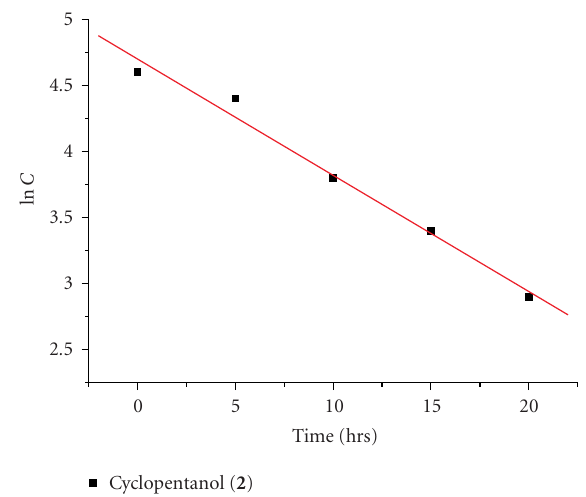
Figure 9: First-order PCO of 2 in acetonitrile ( r = 0 . 9918, k = − 0 . 094 hr − 1